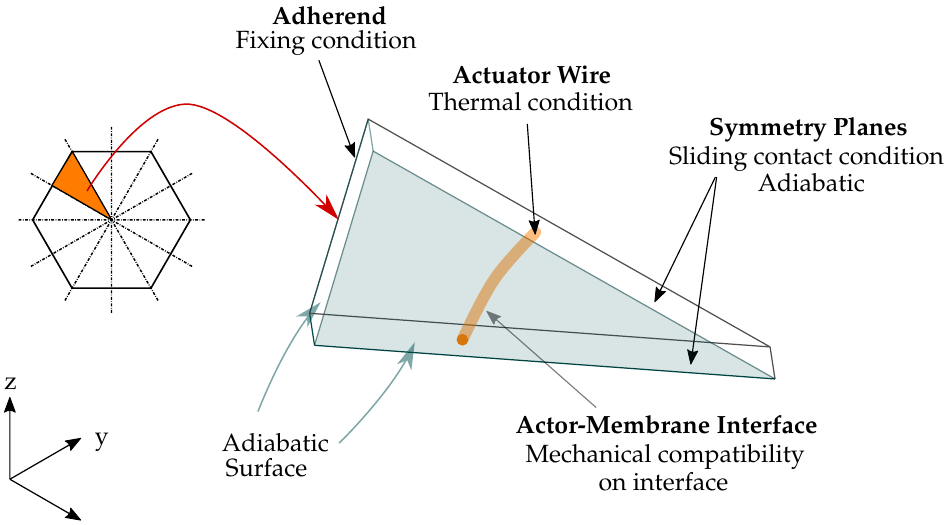
Figure A3. One-twelfth model and conditions for representing the symmetry and external mount